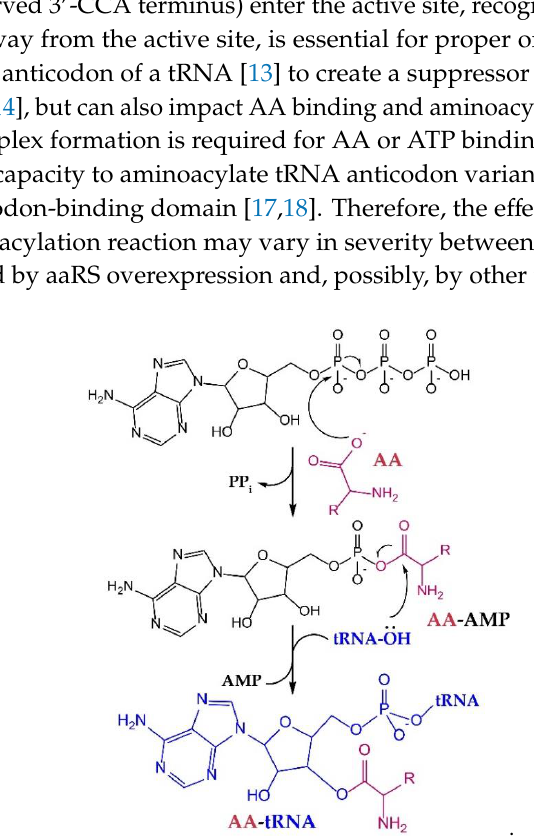
Figure 1. Aminoacyl-tRNA synthetases (aaRSs) catalyze aminoacyl (AA)-tRNA formation in two steps. First, the aminoacyl adenylate (AA-AMP) is formed and the pyrophosphate (PP i ) is released.